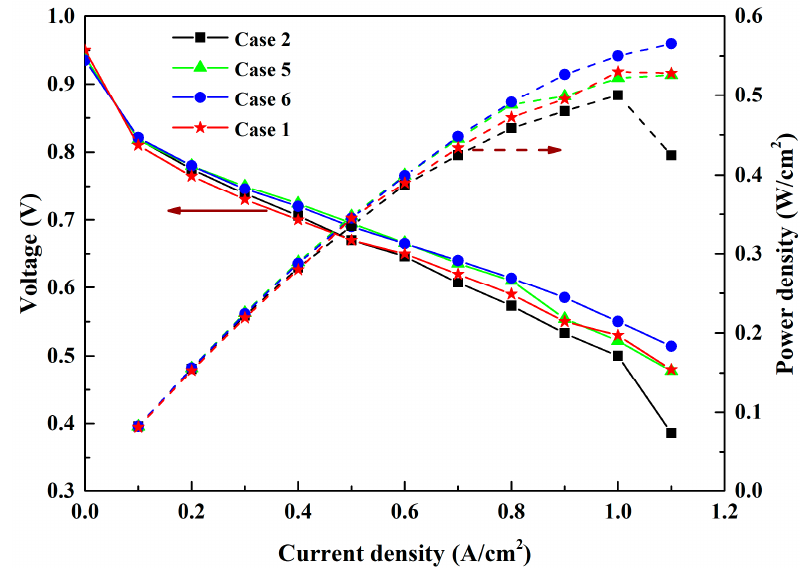
Figure 7. Polarization curve and power density in various RHc cases.